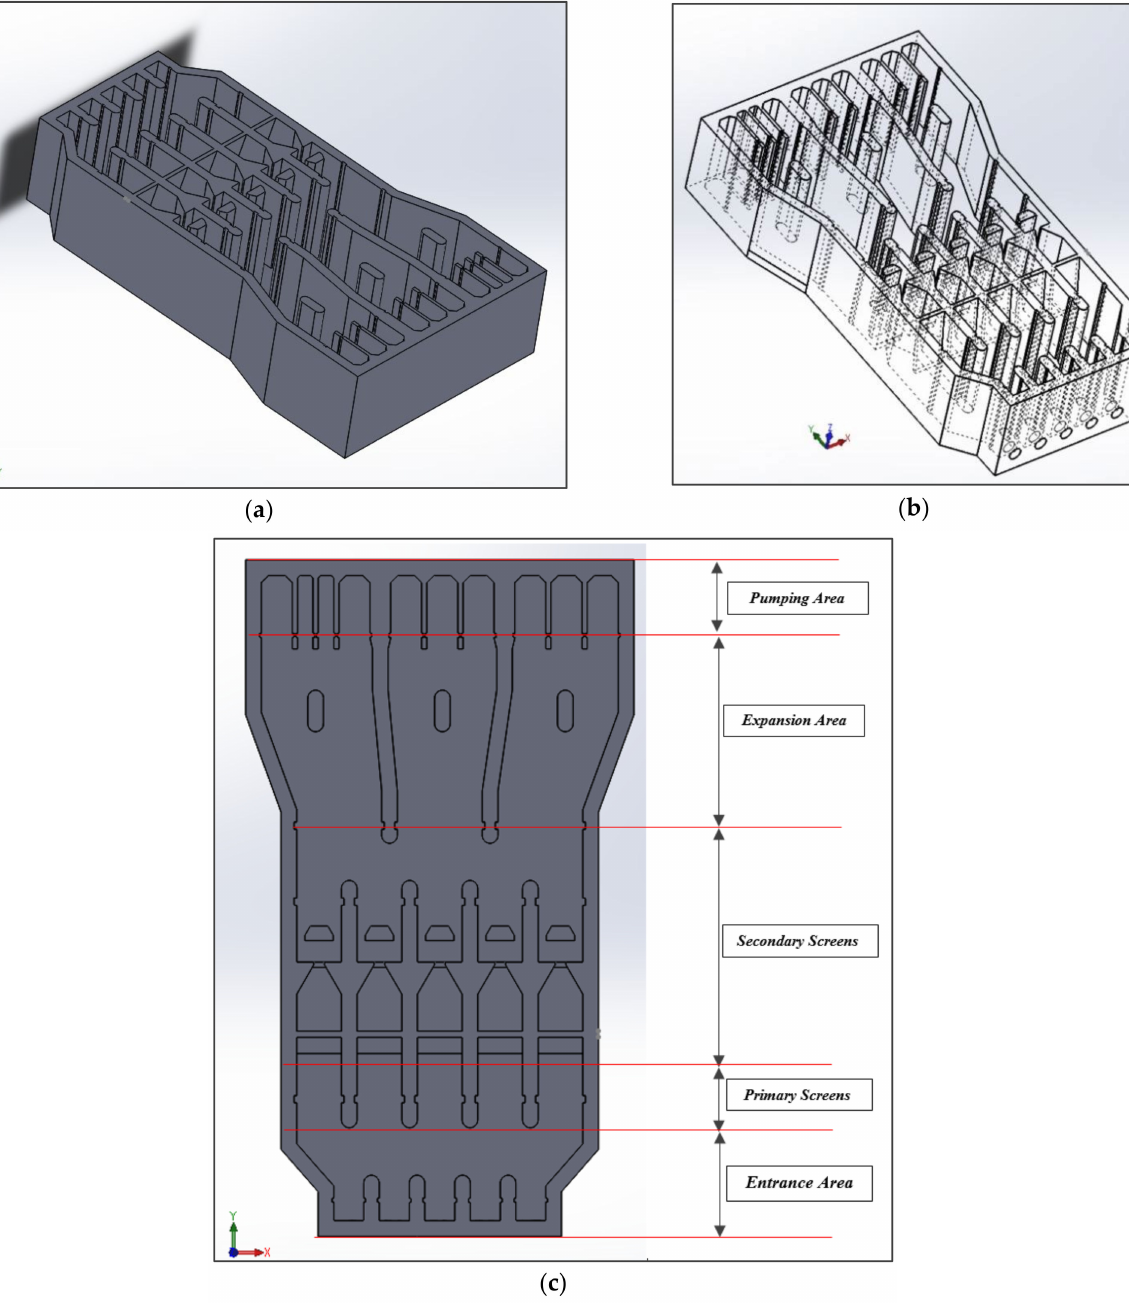
Figure 3. The 3D model of the seawater intake system: ( a ) 3D Drawing View, ( b ) 3D Transparent view; ( c ) Top view with a schematic illustration of the section